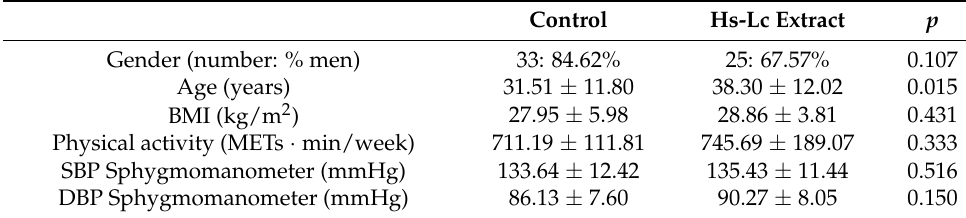
Table 1. Characteristics of the volunteers from the control and experimental ( Hibiscus sabdariffa (HS) and Lippia citriodora (LC)) groups. Body mass index (BMI), metabolic equivalent of task (MET), systolic blood pressure (SBP), and diastolic blood pressure (DBP).